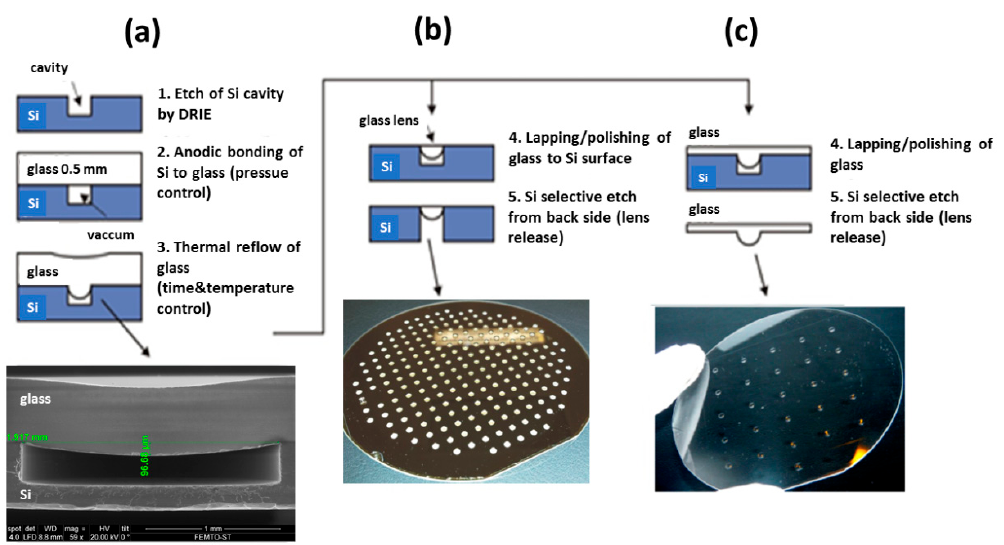
Figure 8. Wafer-level process of plano-convex glass microlenses: ( a ) reflow of glass over cylindrical silicon cavity, ( b ) planarization of glass surface and releasing of microlens by localized back-side Si dry etching or ( c ) by complete removing of silicon substrate. Reproduced with permission from [19], published by SPIE, 2015.